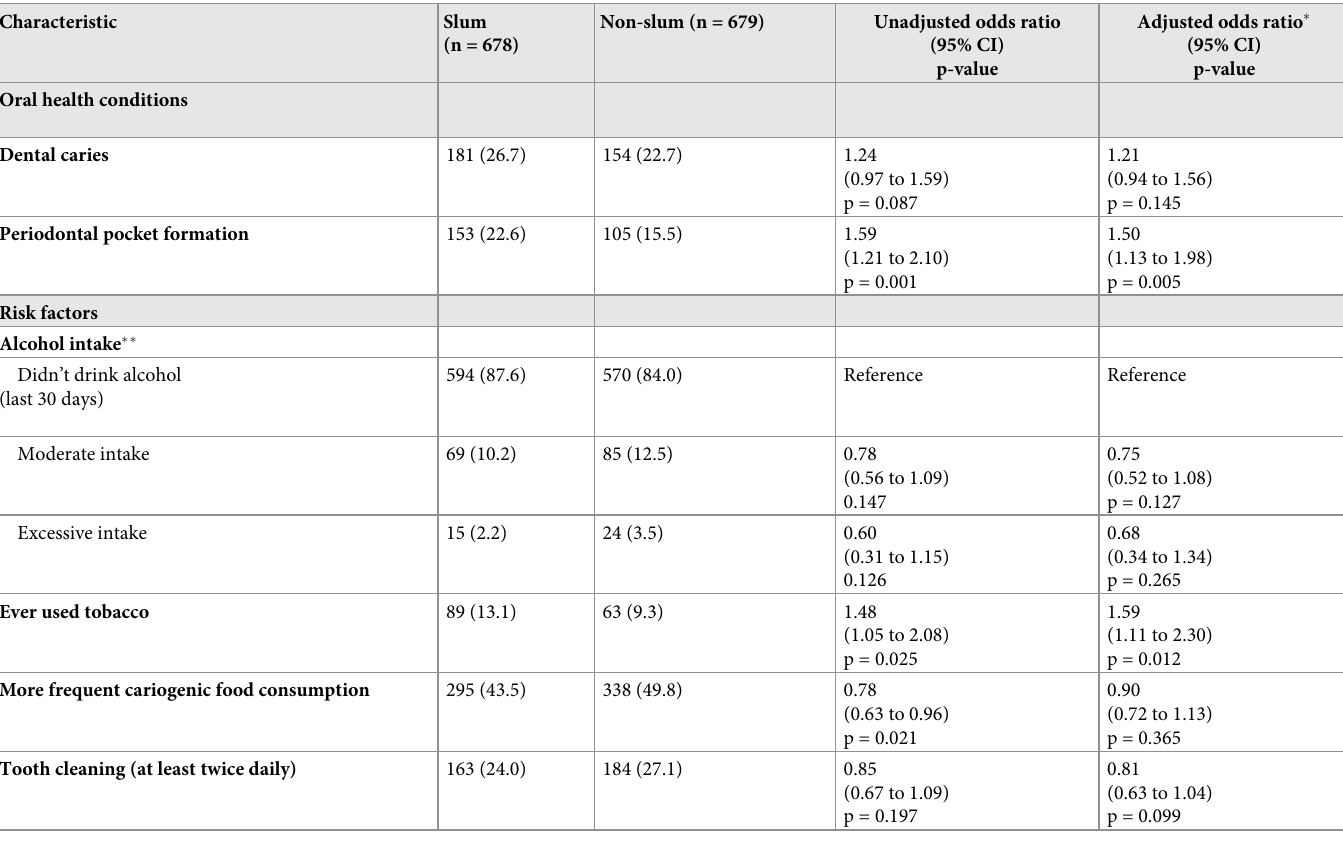
Table 2. Logistic regression models to explore associations between the place of residence and 1) oral health conditions; 2) risk factors, unadjusted and adjusted for age group and sex.